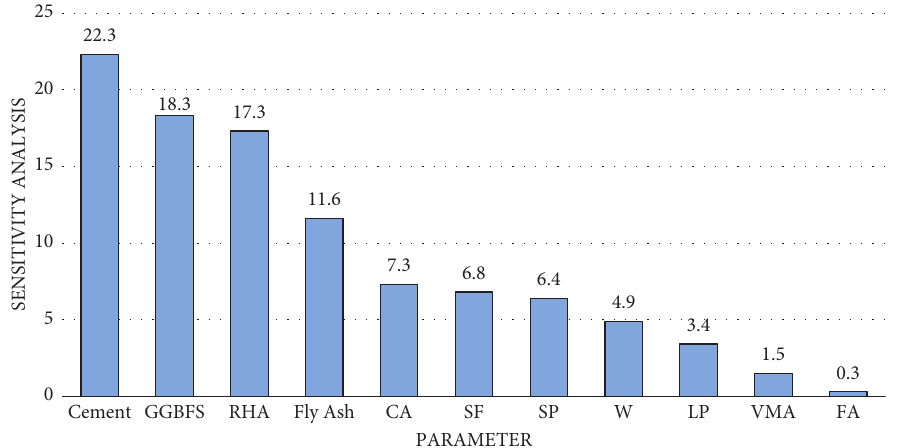
Figure 16: The relative influence of the input parameters on SCC’s compressive strength.